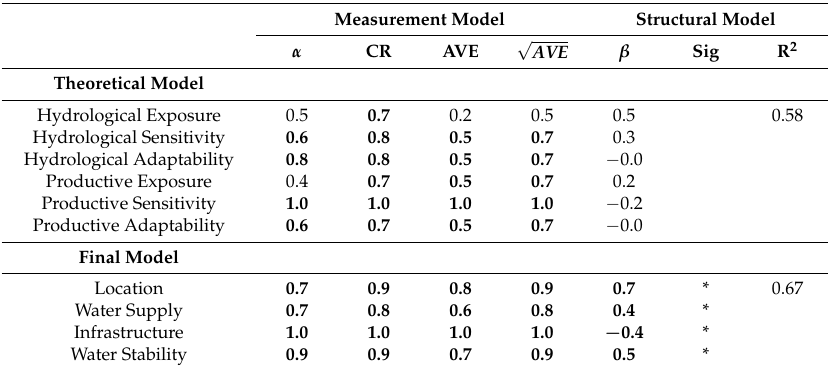
Table 6. Results of measurement and structural model